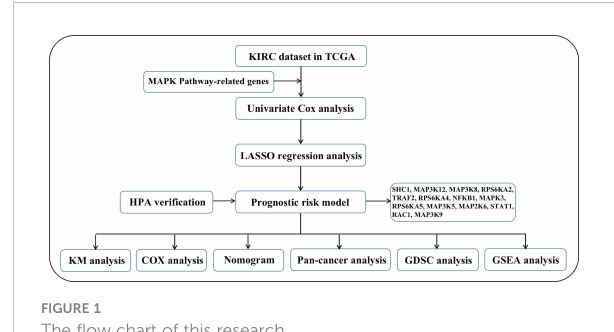
FIGURE 1 The fl ow chart of this